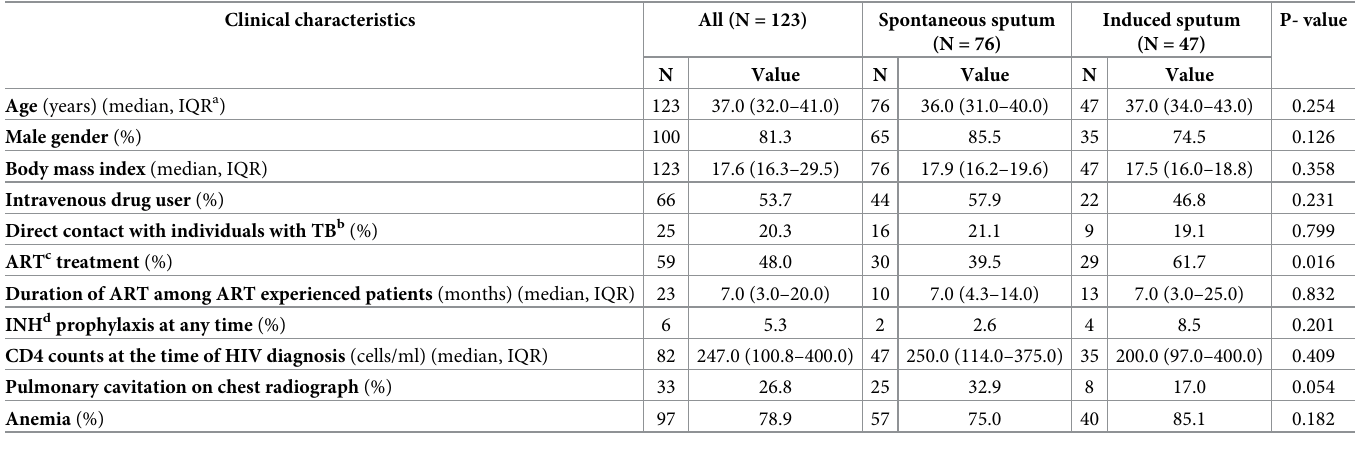
Table 1. Baseline characteristics of study